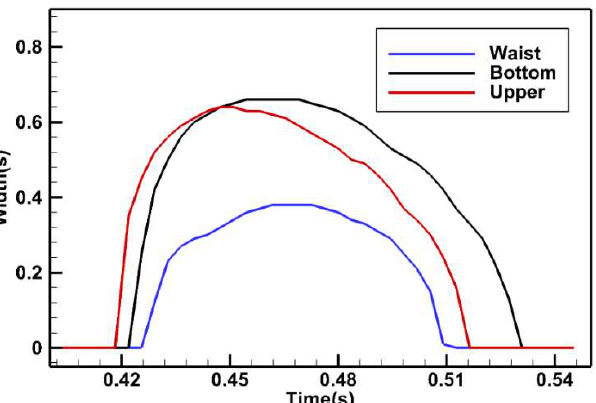
Figure 4. Images showing the 3D weld pool at 0.447 s: ( a ) upper surface, ( b ) longitudinal section at the symmetry plane y = 0 mm, ( c ) bottom surface and ( d ) cross section at the plane x = 24 mm. In terms of validation, the difference between the predicted and experimental WCSs is commonly used to evaluate the predicted accuracy. It is essential to validate the thermal analysis result using the WCS obtained from the maximal temperature field. This is due to the fact that the WCS from the transient temperature field cannot possess max upper/bottom/waist widths simultaneously, and this can result in extra errors. Taking the WCS at 0.447 s as an example, the section is shown on the plane x = 24 mm in Figure 4d, and changes in its upper/bottom/waist widths over time are shown in Figure 5. It can be seen that the times when the widths reached their maximum were 0.447 s, 0.455 s and 0.462 s. The corresponding max widths were 1.28 mm, 1.36 mm and 0.74 mm, while the widths in Figure 4d were 1.28 mm, 1.28 mm and 0.62 mm. The bottom and waist widths had differences of 0.08 mm and 0.12 mm. Validation using the WCS in Figure 4d could result in extra errors of 5.88% (bottom width) and 16.2% (waist width).